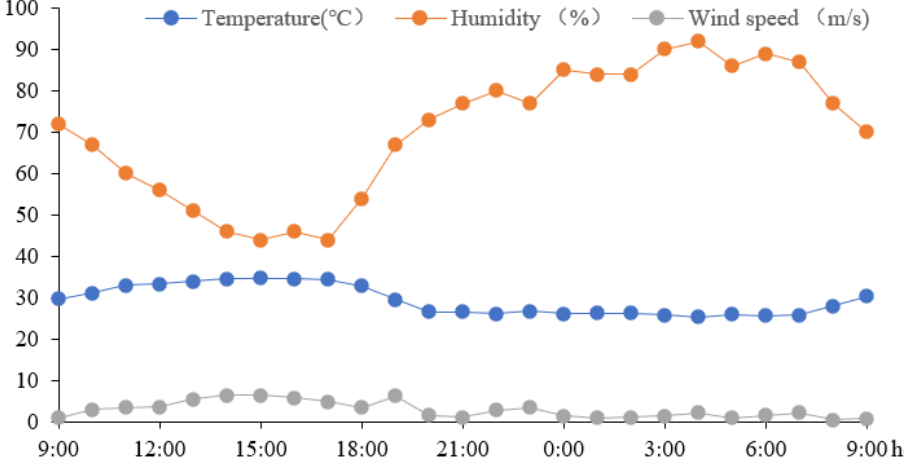
Figure 4. The daily variations of the air temperature, humidity, and wind speed.